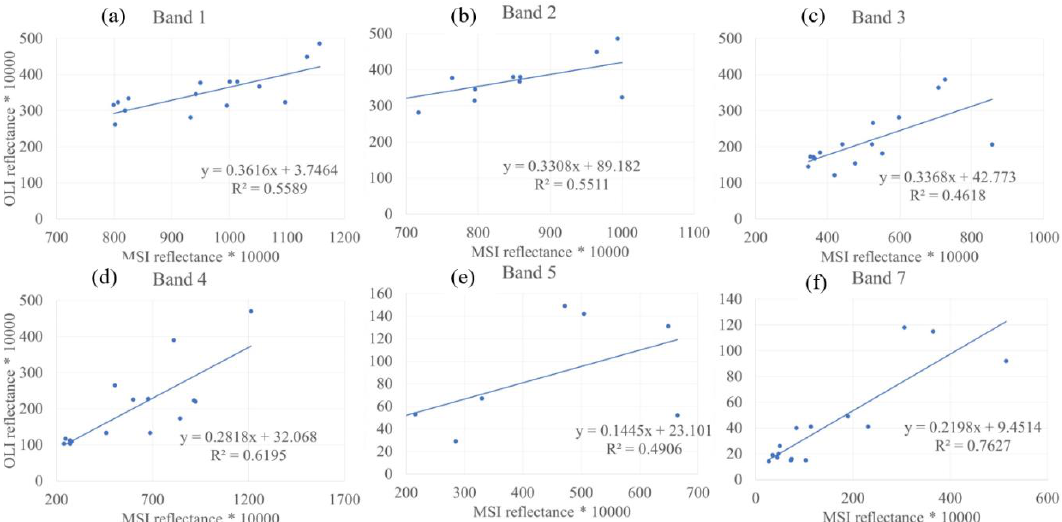
Figure 4. Band calibration between Sentinel-2 MSI ( x -axis) and Landsat 8 OLI ( y -axis) surface reflectance: ( a ) Band 1; ( b ) Band 2; ( c ) Band 3; ( d ) Band 4; ( e ) Band 5; ( f ) Band 7. (Note: the x axis and the y axis of the charts mark the reflectance values multiplied by 10,000). For consistency, the band names refer to the Thematic Mapper bands.